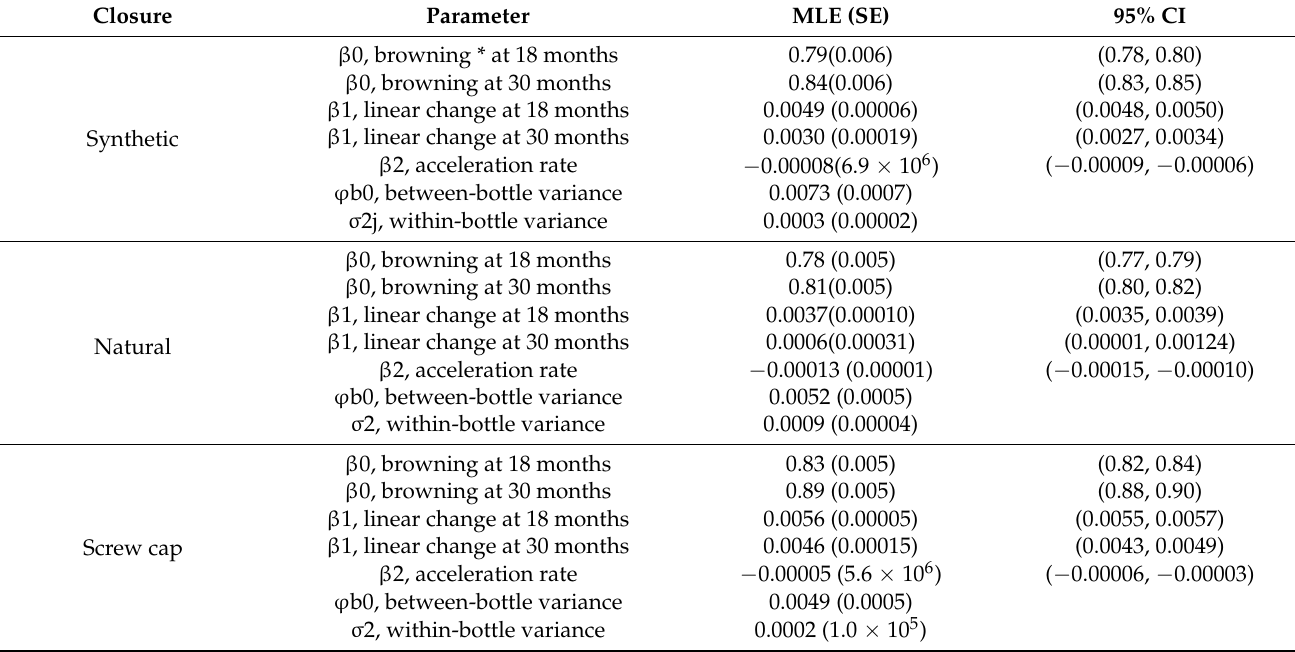
Table 2. Maximum likelihood estimates (MLE) of the growth model parameters by